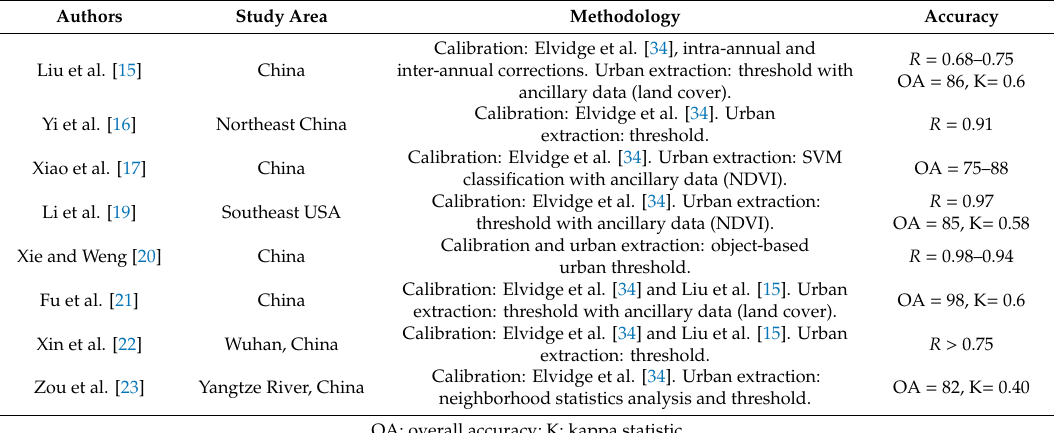
Table 1. Comparison of previous research on urban areas measured by night-time lights.